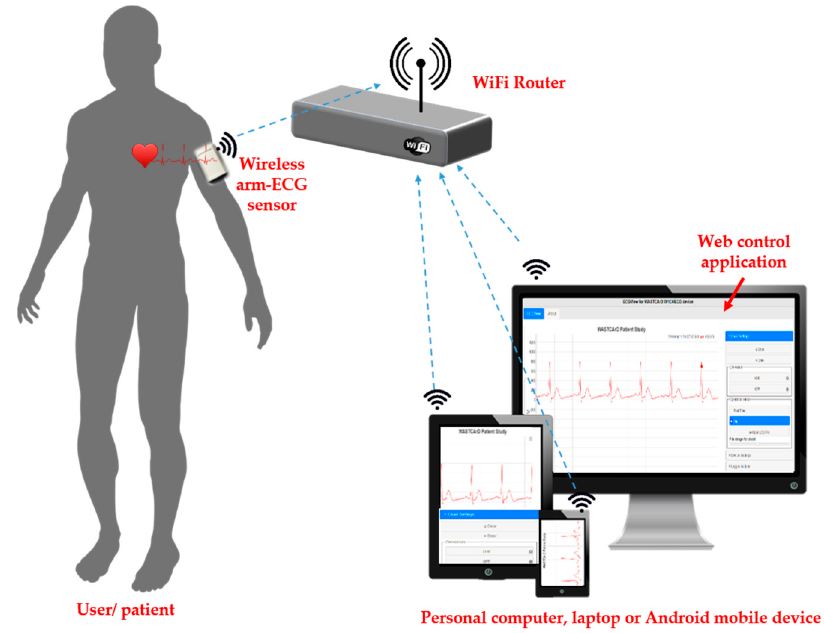
Figure 5. Functional diagram of the developed arm-ECG wireless sensor system